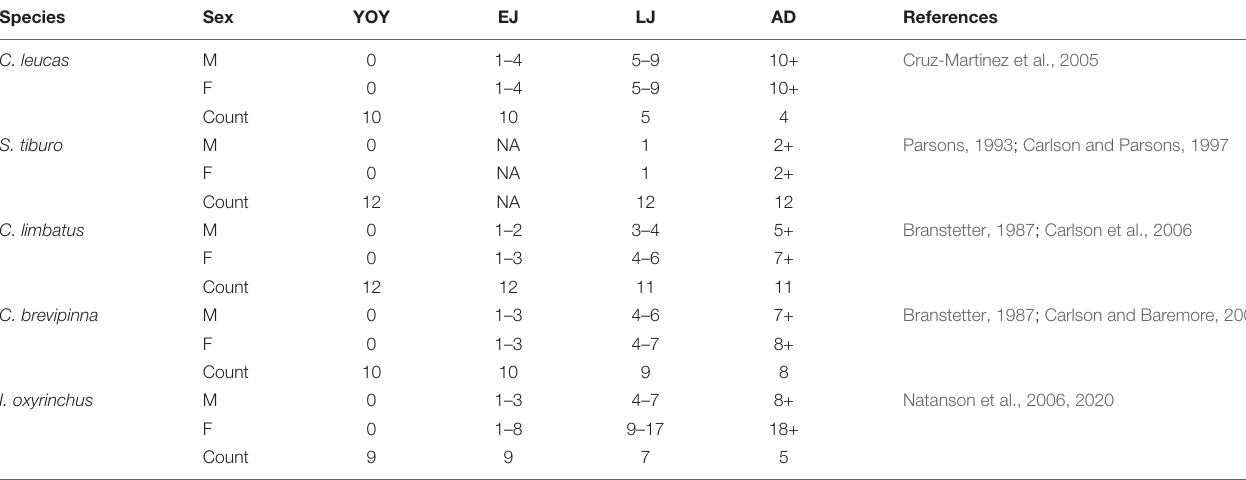
TABLE 2 | Life stage classifications for each shark species by sex: young-of-the-year (YOY), early juvenile (EJ), late juvenile (LJ), and adult (AD). Species Sex YOY EJ LJ